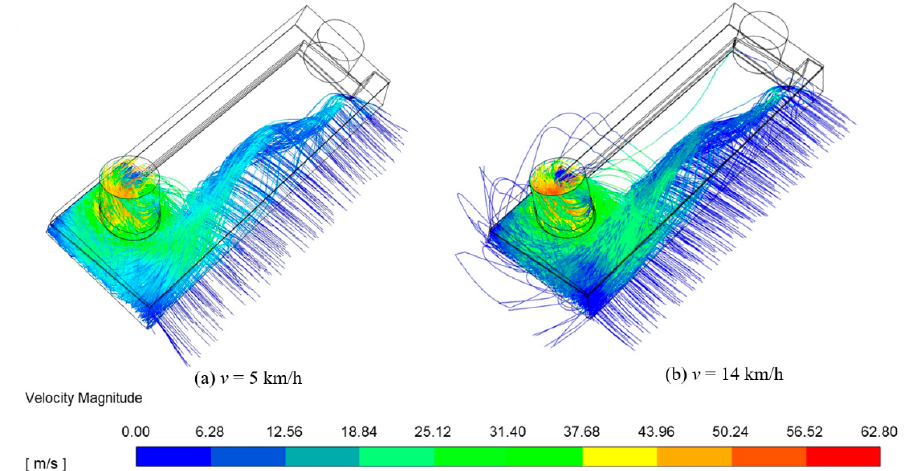
Figure 13. Particle velocities and trajectories under different traveling speeds:( a ) traveling speed is 5 km/h; ( b ) traveling speed is 14 km/h; 5 km / h; ( b ) traveling speed is 14 km / h.